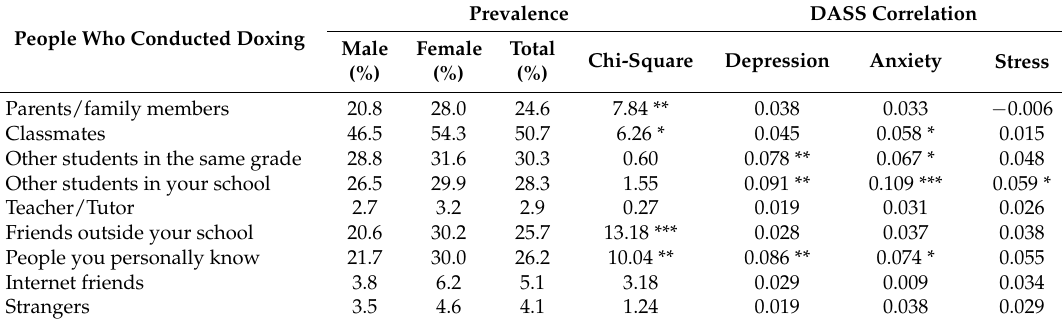
Table 2. People who conducted the doxing and associations with DAS of victims ( n = 2120). Prevalence DASS Correlation People Who Conducted Doxing Male Female Total Chi-Square Depression Anxiety Stress (%) (%) (%) Parents/family members 20.8 Classmates 46.5